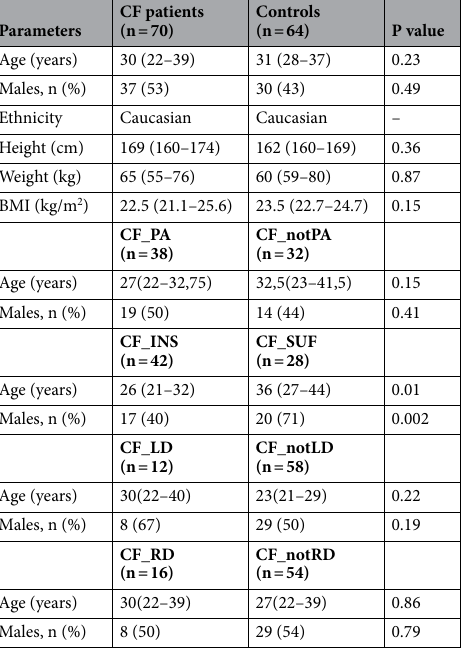
Table 1. Main features of CF patients and controls. Continuous data are reported as median (interquartile